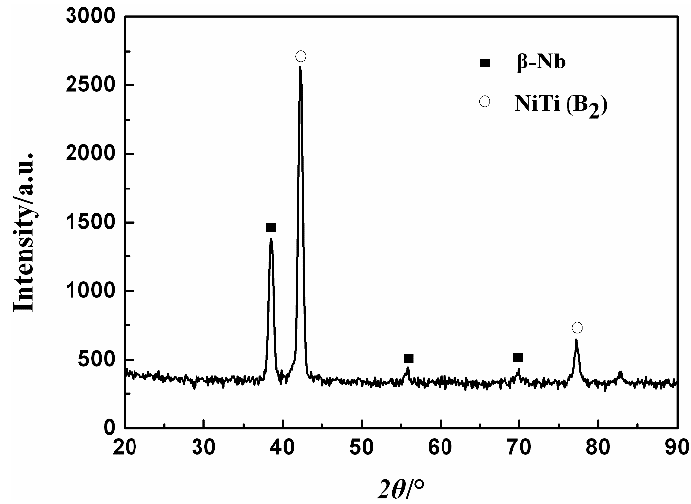
Figure 2. X-ray di ff raction (XRD) patterns of Samples A, B and C, with the β -Nb and NiTi (B 2 ) Figure 2. X-ray diffraction (XRD) patterns of Samples A, B and C, with the β -Nb and NiTi (B 2 ) peaks peaks identified. identified.